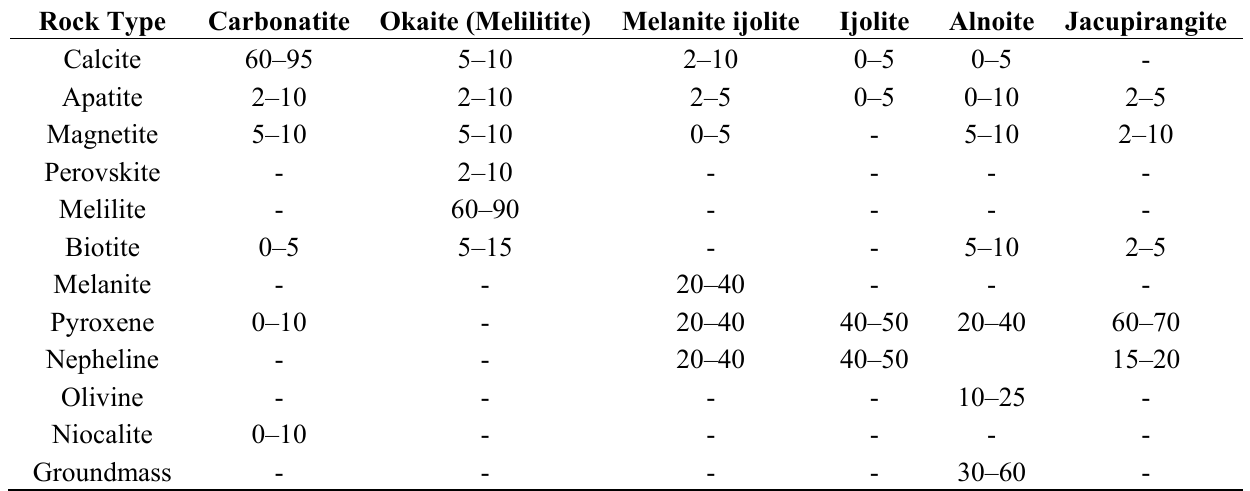
Table 1. Summary of the mineralogy of the main rock types at Oka.